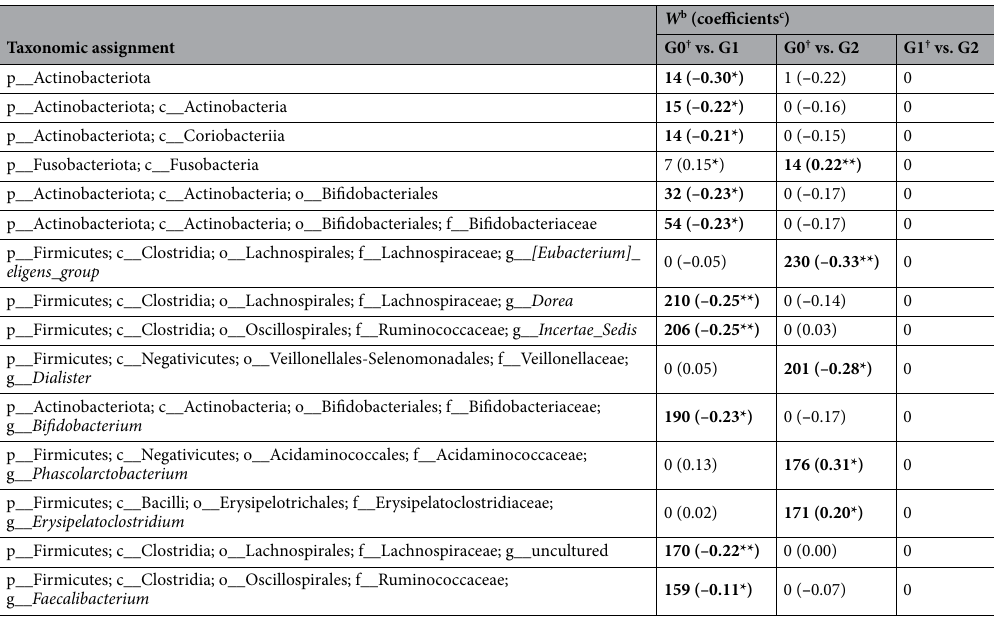
Table 2. Comparison of the microbial relative abundances between pairwise groups according to renal stone status at the phylum, class, order, family, and genus levels. p__: phylum, c__: class, o__: order, f__: family, g__: genus, s__: species, G0: no renal stone group, G1: incidental renal stone group, G2: prevalent renal stone group. a Number of phyla, 15; classes, 23; orders, 50; families, 89; genera, 260. b W = X for taxon k, then H 0k is rejected X times. The W statistics for the significantly different taxa relative to over 60% of the other taxa at each taxon level are represented in bold. c Coefficients for the log-transformed relative abundance of each taxon in the linear model adjusted for age, sex, and BMI using MaAsLin2 on pairwise comparisons between groups. * p < 0.05, ** p < 0.01. † Group used as the reference group in the regression